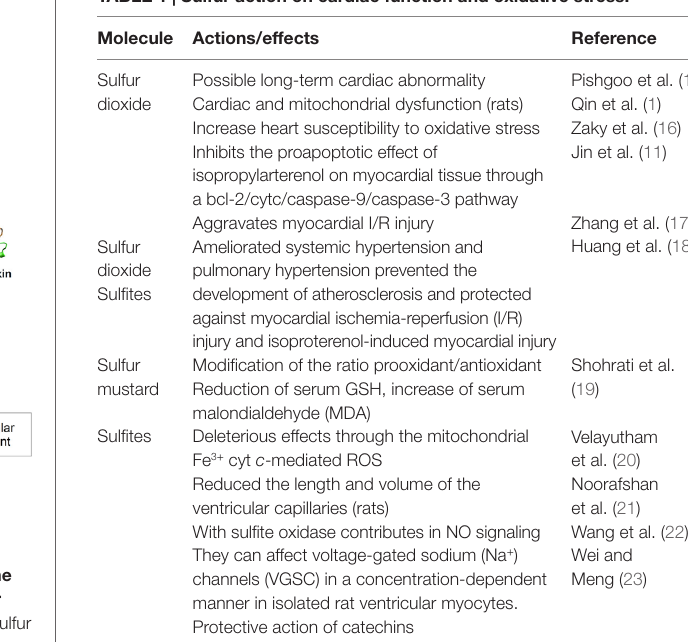
taBle 1 | Sulfur action on cardiac function and oxidative